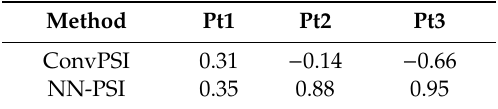
Table 3. The correlation between SBAS and PSI